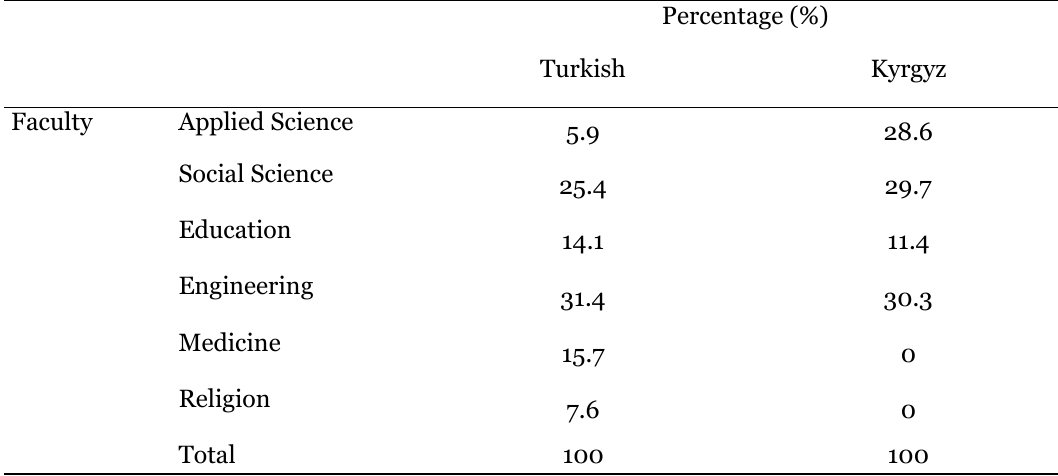
Percentage of Students by